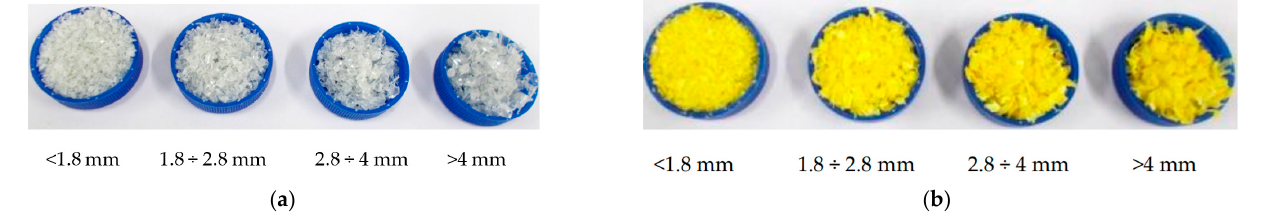
Energies 2021 , 14 , x FOR PEER REVIEW